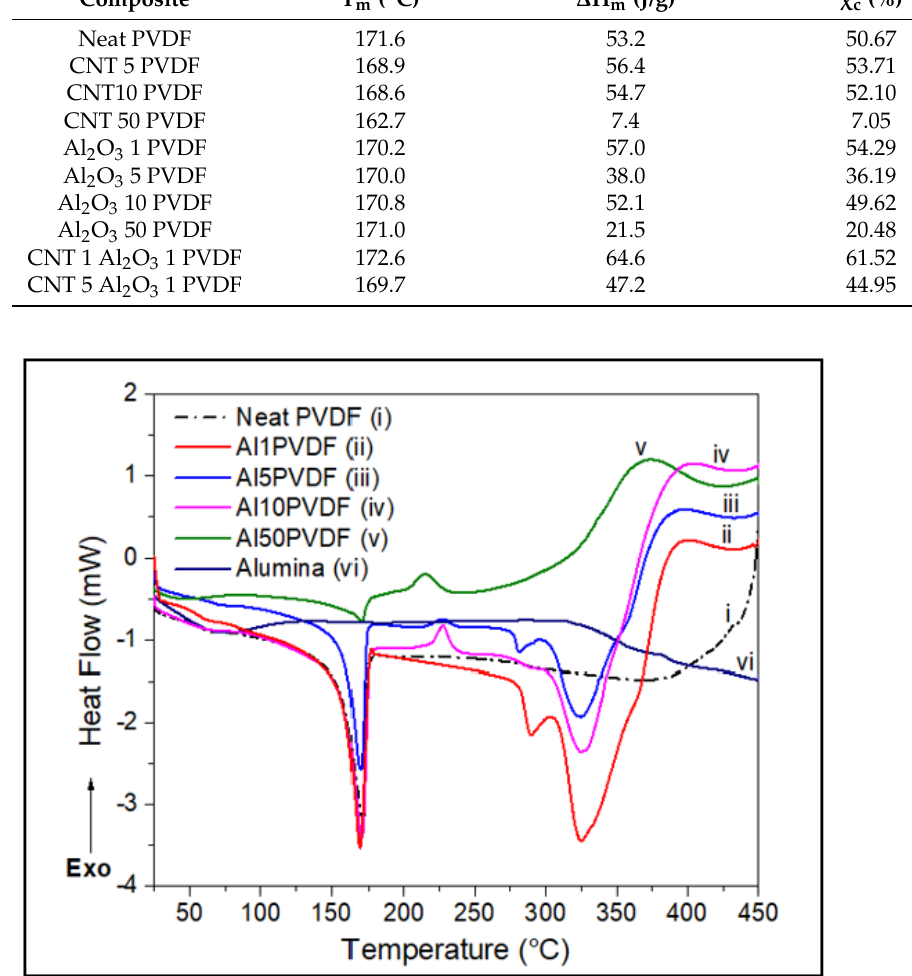
Figure 1. DSC comparisons of effect of Alumina wt.% loadings on PVDF thermal properties.